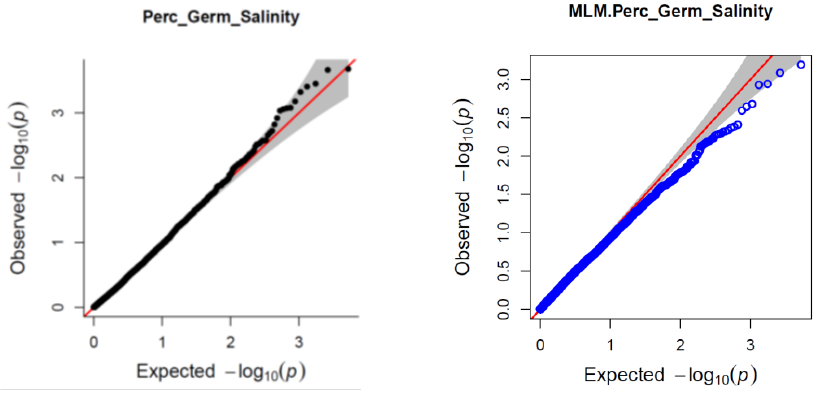
Figure 1. Quantile-Quantile (QQ) plots of FarmCPU ( A ) and GAPIT-MLM ( B ) genome-wide association study (GWAS) models.